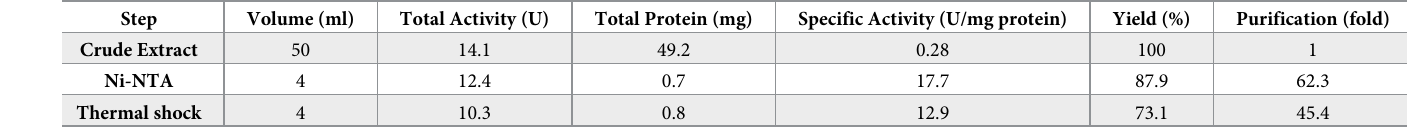
Table 1. Protein activity and concentration, purified using Ni-NTA chromatography and single-step thermal shock. Step